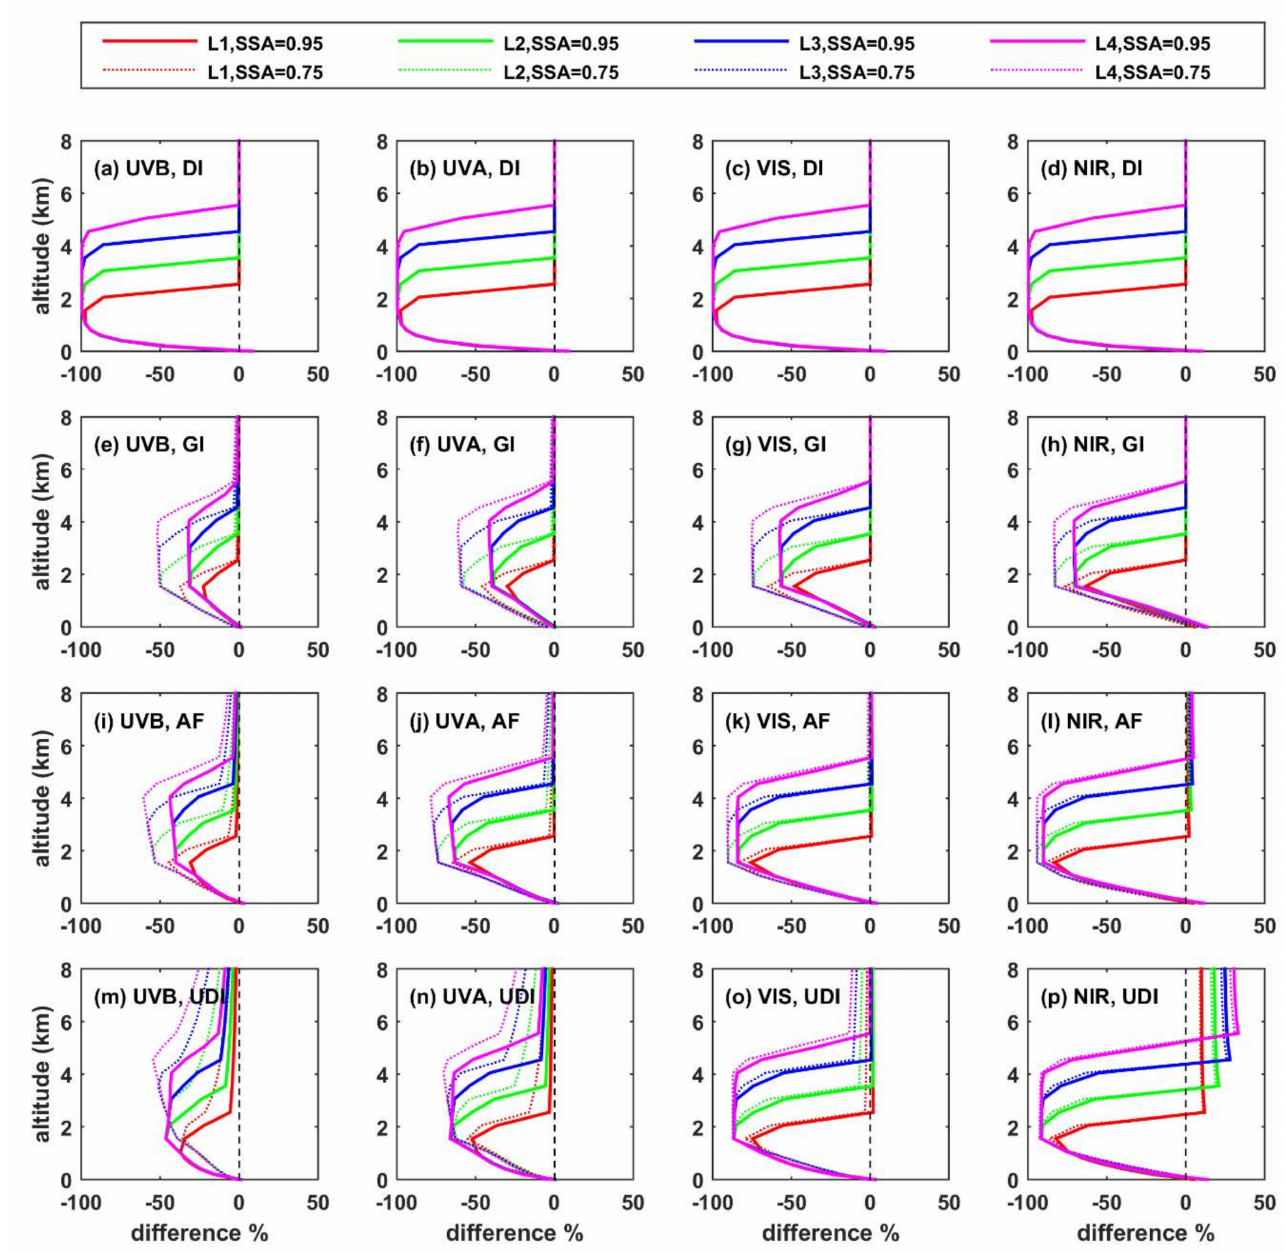
Figure A4. Same as Figure 3, but for SZA = 80 ◦ instead of SZA = 60 ◦